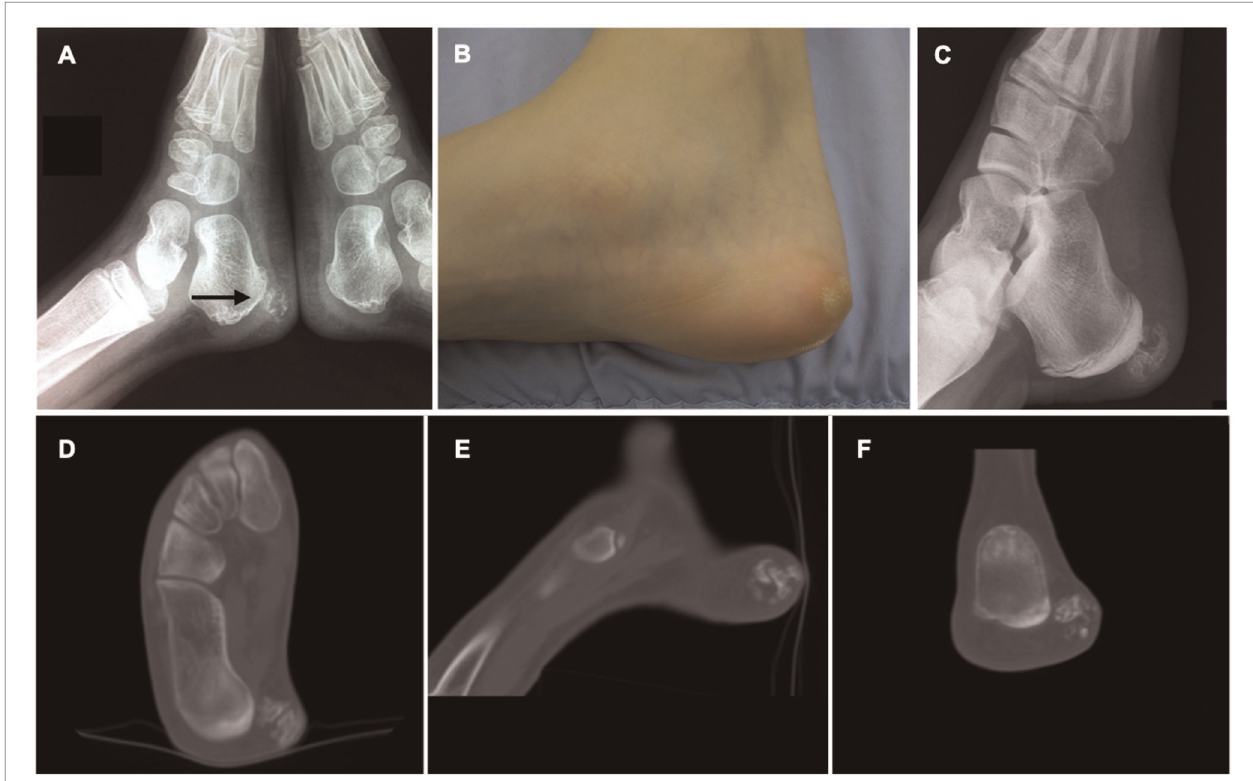
FIGURE 1 | ( A ) Old X-ray showing the clinically silent lesion at the age of 6 years. ( B ) Clinical picture showing the mass covered with areas of hyperkeratosis. ( C ) New X-ray at time of presentation showed increased size of the lesion. ( D – F ) Preoperative CT section of the